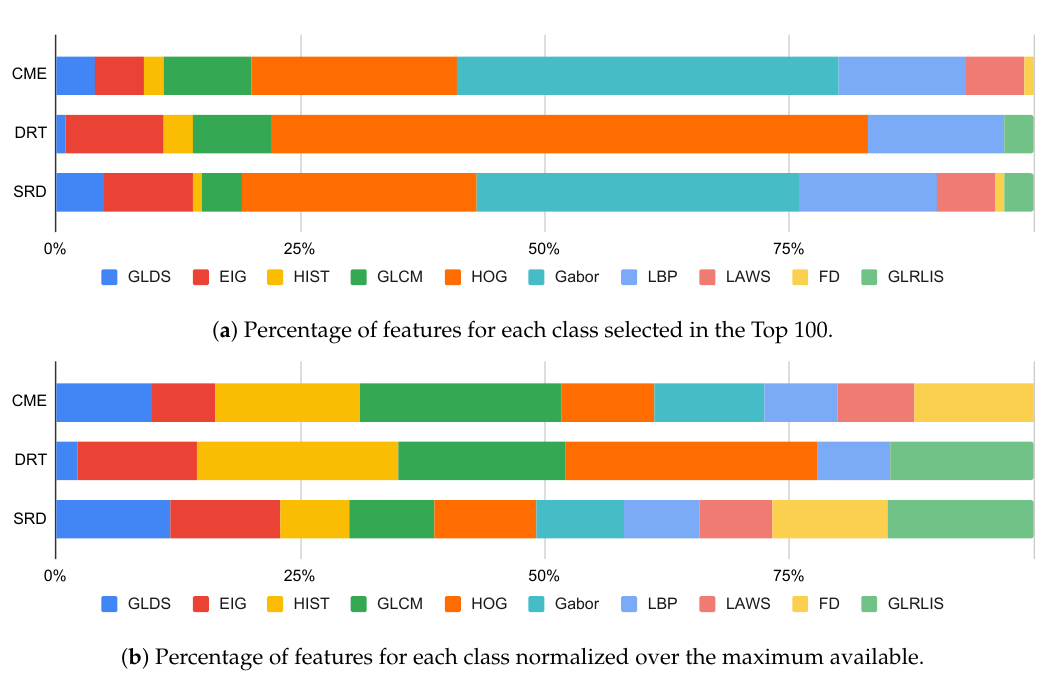
Figure 9. Feature selection results obtained with the SFS strategy for each DME type and considered feature families displayed in Table